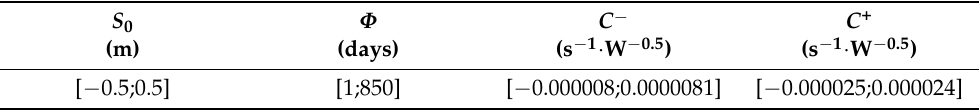
Table 1. Initialization of the 4 free model parameters.